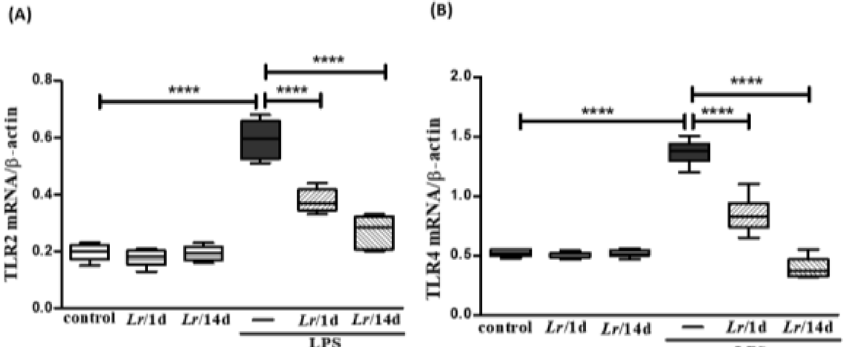
Fig. 7 represents the pulmonary edema in response to LPS instilla- tion. In this assay, the authors determined vascular permeability in the lung using the Evans blue extravasation technique 24 h after LPS. The Evans blue extravasation into the lung was signi fi cantly higher in com- parison with the control group. It is observed that both Lr /1d+LPS and Lr /14d+LPS signi fi cantly reduced pulmonary microvascular leakage 24 h after LPS. The results did not indicate a signi fi cant difference between the groups ' control, Lr /1d and Lr /14d.